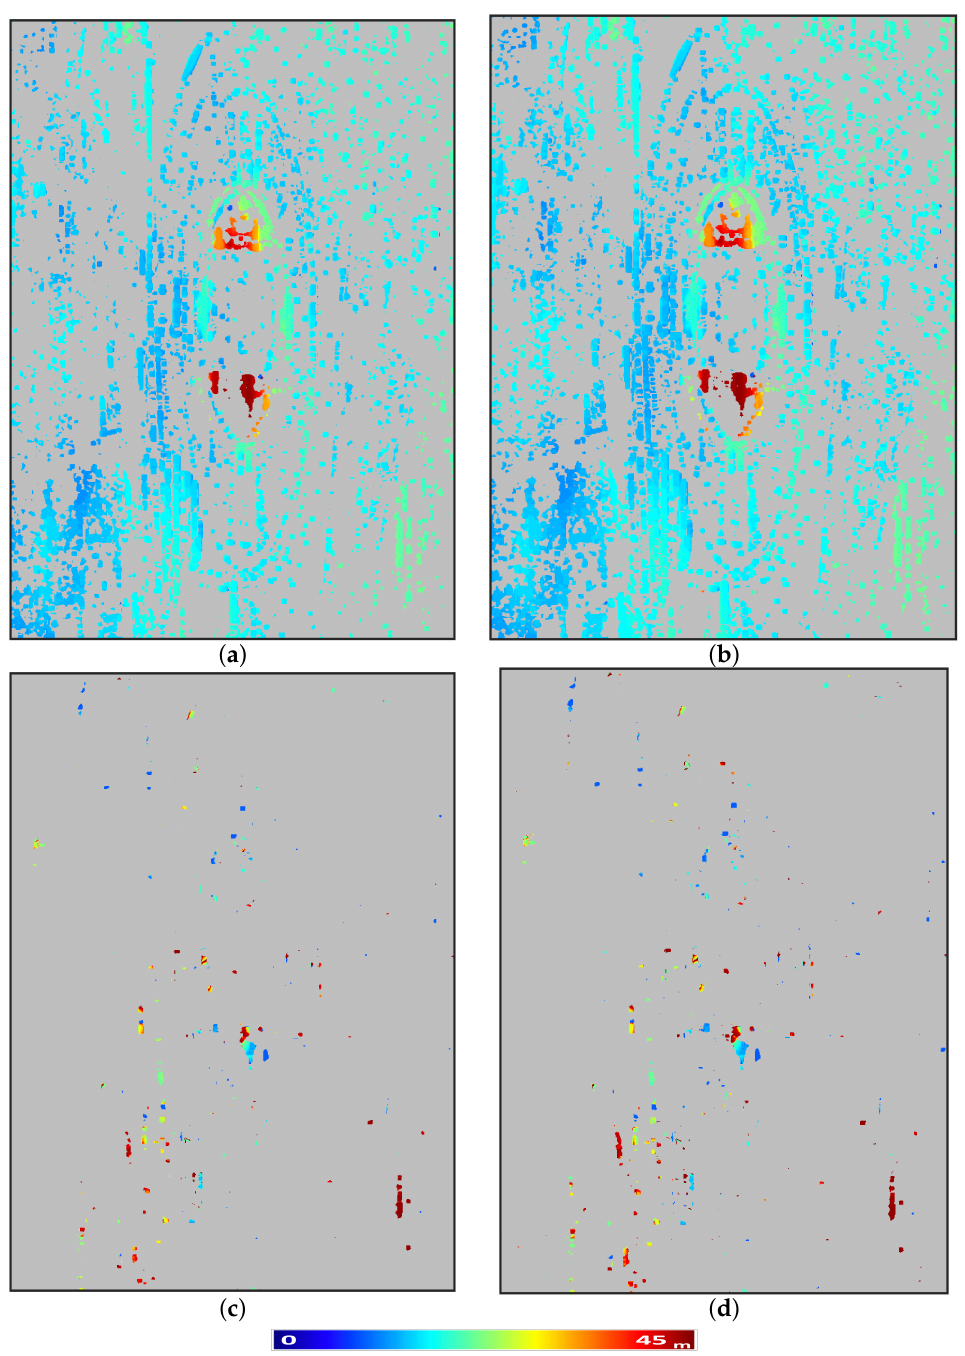
Figure 7. Performance assessment of the employed methods using the UAVSAR real data set. ( a , b ) detected single scatterers using the existing scattering-based support GLRT (10) and the proposed detection (16). ( c , d ) detected double scatterers using the scattering-based support GLRT (11) and proposed detection (17). The colors of the scatterers show their elevations when the standard JET colormap is set to the range of [0–45